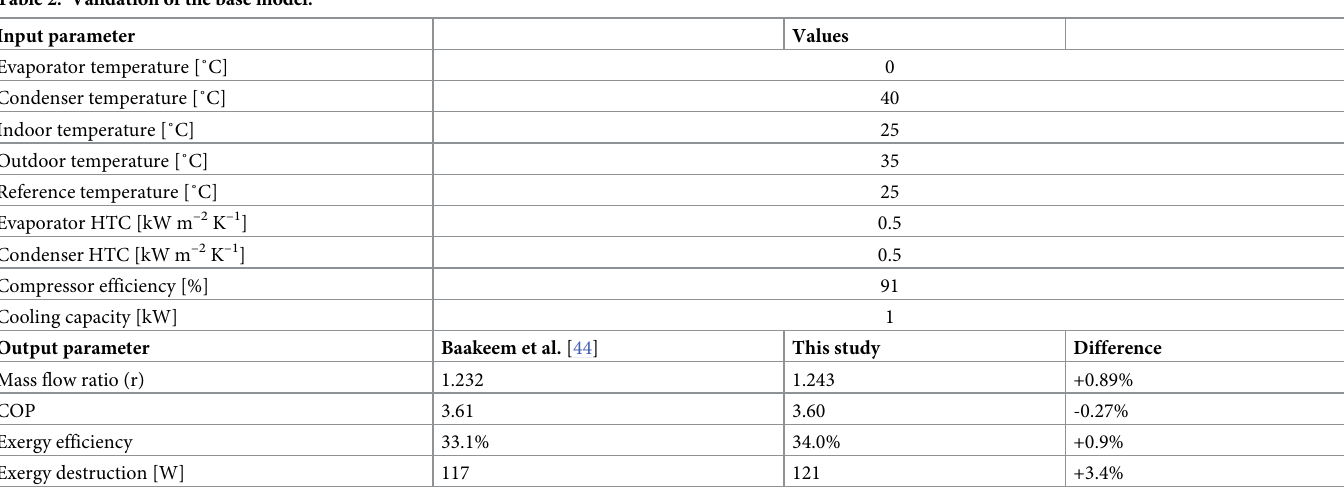
Table 2. Validation of the base